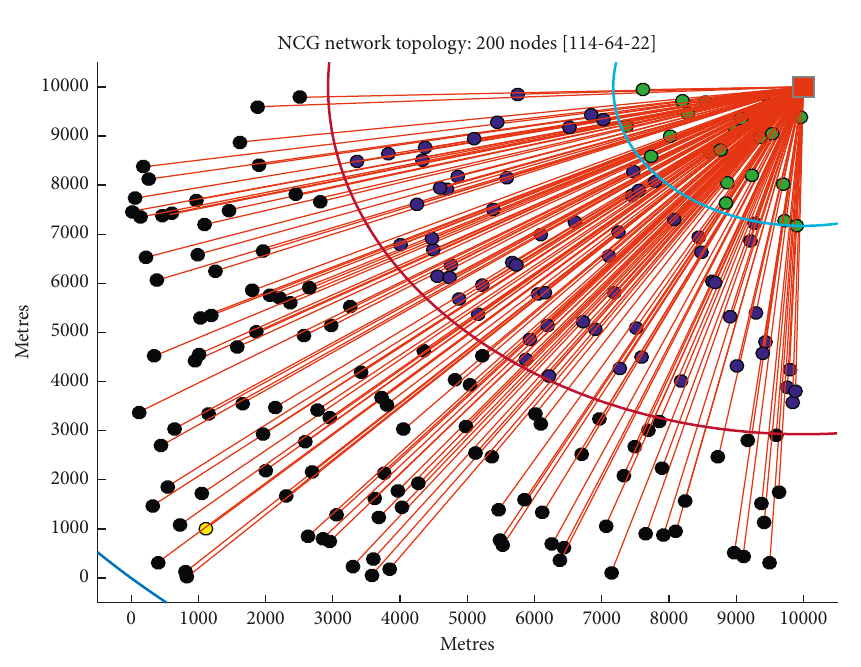
Figure 5: NCG simulation scenario.